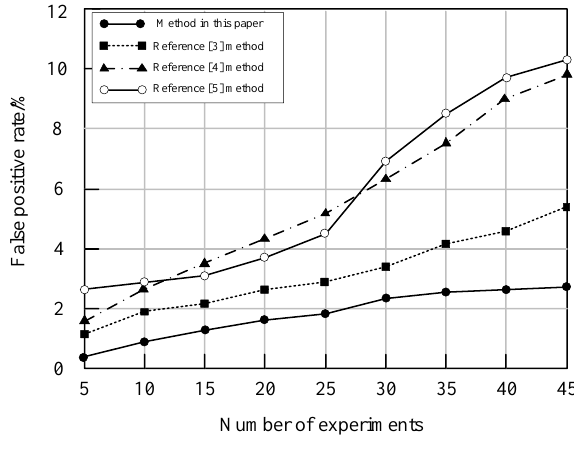
Figure 4. Comparison of false alarm rates of each diagnostic method